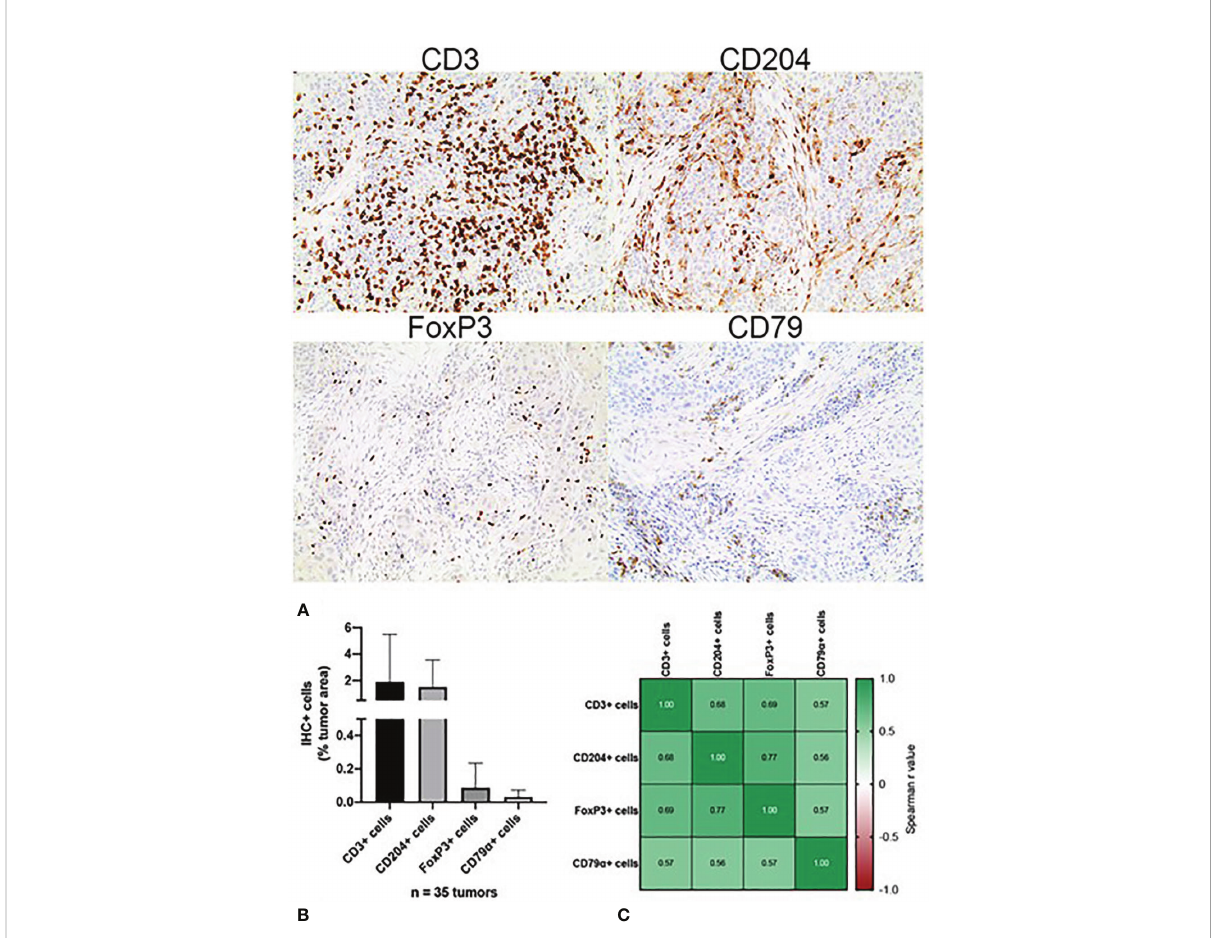
FIGURE 1 Immunohistochemical characterization of the immune landscape of canine OSCC. (A) Representative photomicrographs of CD3+, CD204+, FoxP3+ and CD79a+ tumor in fi ltrating leukocytes. 10x magni fi cation. (B) Quanti fi cation of tumor-in fi ltrating leukocyte density according to cell type, as determined by quantitative whole slide image analysis. Data represent mean +/- S.D. (C) Correlation matrix of Spearman r values demonstrating association between the densities of each tumor-in fi ltrating leukocyte